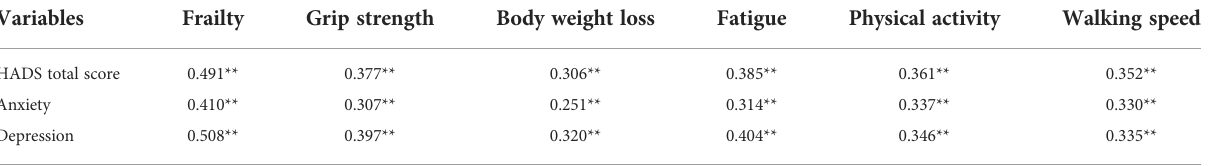
TABLE 8 Correlation analysis among frailty and anxiety and depression (N = 302).